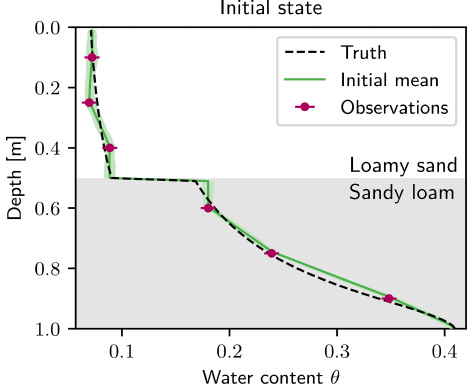
Figure 4. Initial state for the data assimilation run. Observations (purple) at time zero are connected linearly and set constant towards the layer and upper boundary. For the lower boundary, the saturated water content θ r = 0 . 41 of sandy loam is used for the interpolation. The ensemble with 100 ensemble members is generated by perturb- ing the interpolated state using a spatially correlated Gaussian dis- tribution. The 95% quantile of the initial ensemble is shown in light green. The initial truth that is used for the observations (purple) is shown as a black dashed